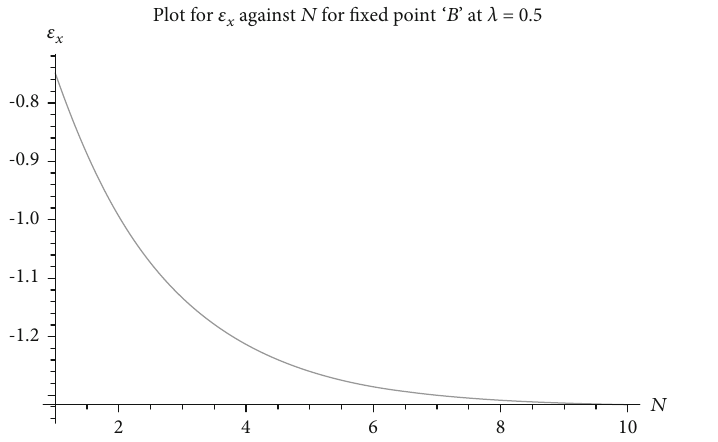
Figure 13: Shows the variation of perturbations along the x -axis ( ϵ